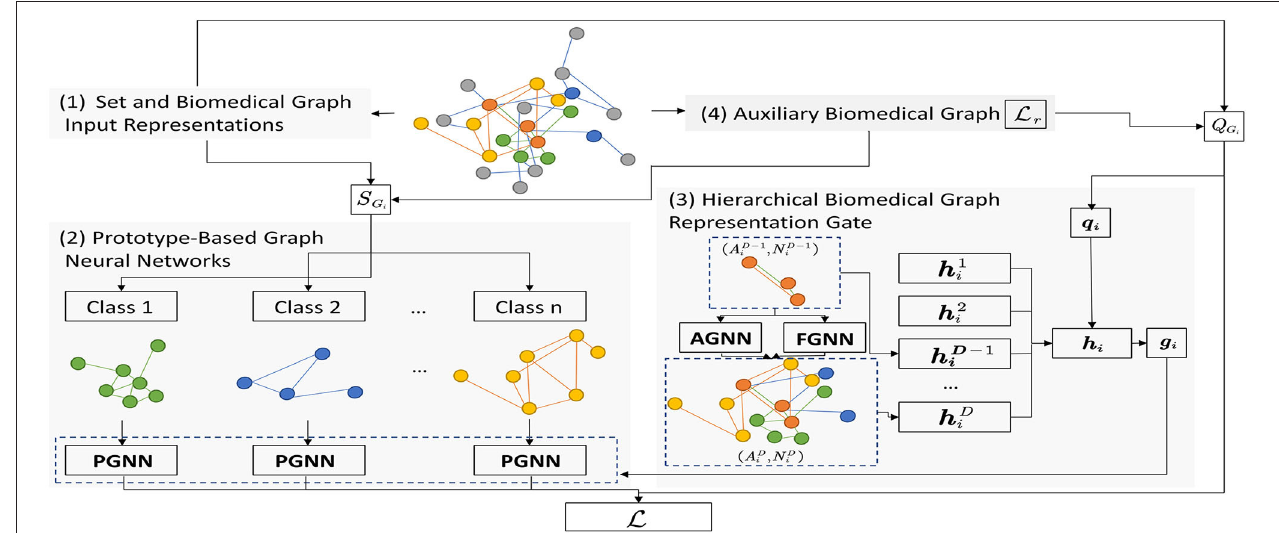
FIGURE 1 | The overall framework of